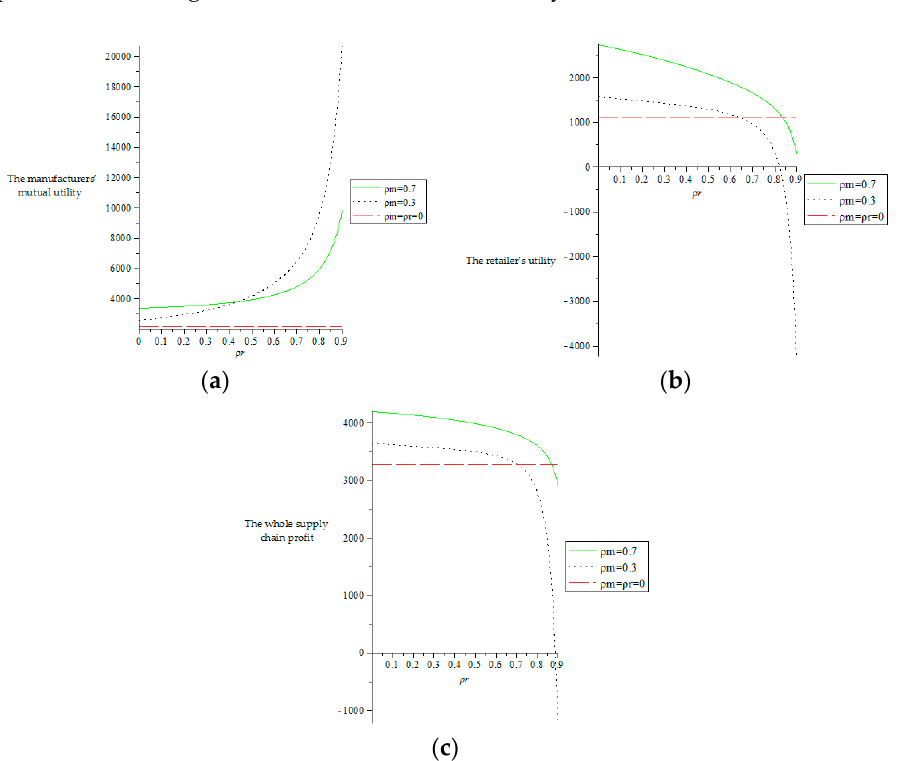
Figure 7. The effect of altruistic preference coefficients of two manufacturers and the retailer on the utilities and profits of the supply chain members. ( a ) The impact of altruistic preference coefficients of two manufacturers and the retailer on the mutual utility of two manufacturers. ( b ) The impact of altruistic preference coefficients of two manufacturers and the retailer on the utility of the retailer. ( c ) The impact of altruistic preference coefficients of two manufacturers and the retailer on the whole supply chain profit.